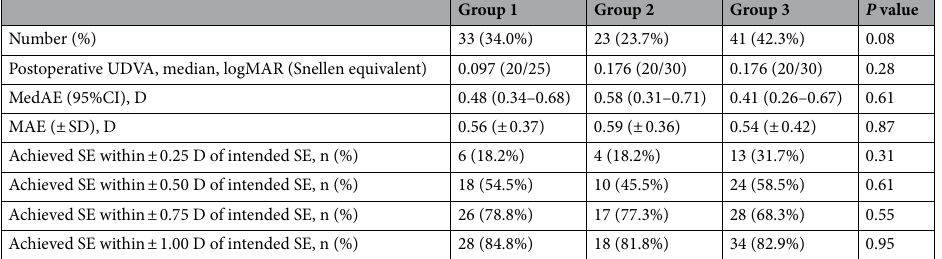
Table 3. Comparison of uncorrected distance visual acuity (UDVA) and refractive prediction error between groups. There was no statistically significant difference in refractive prediction error 1 month post-operatively among the groups. Group 1 preoperative same as Intraoperative intraocular lens power suggestion, Group 2 preoperative suggestion selected, Group 3 intraoperative suggestion selected, UDVA uncorrected distance visual acuity, logMAR log minimum angle of resolution, MedAE median absolute error, CI confidence interval, MAE mean absolute error, SE spherical equivalent.